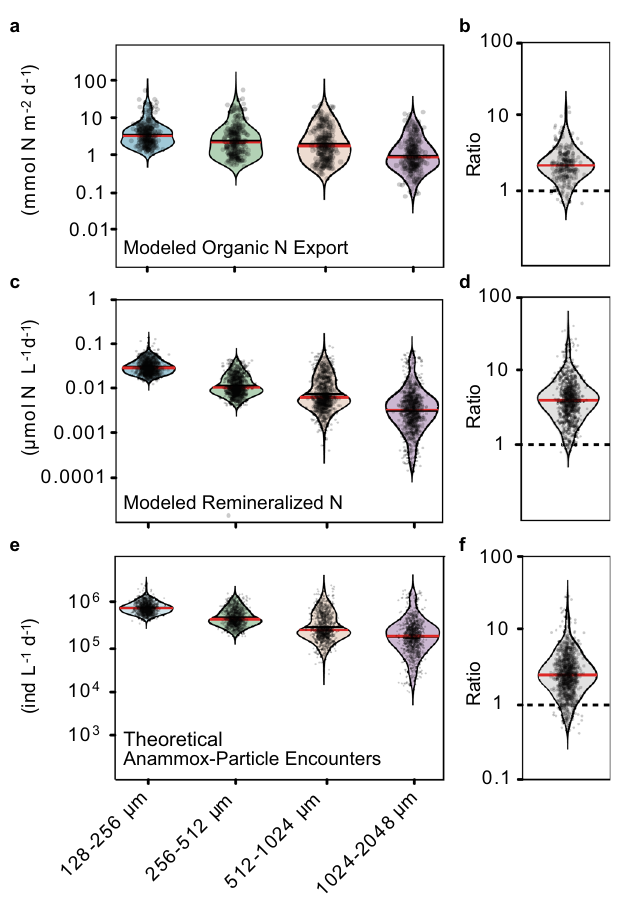
Fig. 5 Transport of nitrogen (N) from the euphotic zone through the water column. a Modelled export of organic nitrogen from the euphotic zone into the oxygen minimum zone, c modelled nitrogen remineralization associated with particles in the anoxic water column ( e ) theoretical number of encounters between anammox bacteria and the particle boundary layer (see text for further information). b , d and f indicate the ratio of processes between the smaller (128 – 512 µ m) and larger particles (512 – 2048 µ m) from ( a , c and e ,) respectively. Ind: individuals. The outlines of the violin plots depict the kernel density estimation of the data points shown. The solid black line and solid red line indicate mean and median,